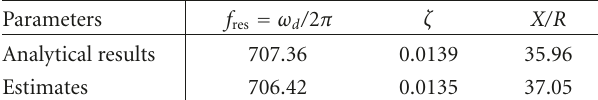
Table 1: Estimation results for case (a) with d 1 = 3